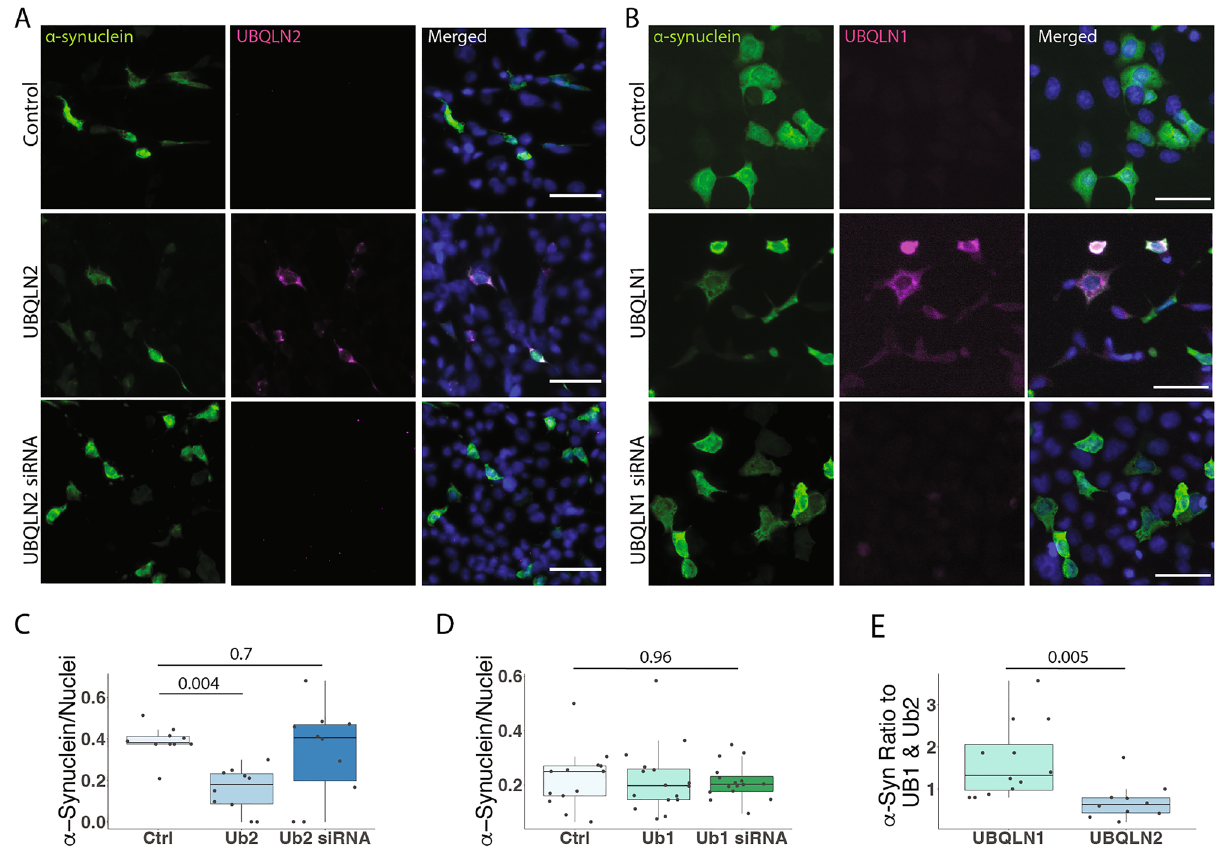
Figure 3. UBQLN2, but not UBQLN1, lowers α-syn levels in HEK-293 cells. ( A – D ) Representative immunofluorescence images show that the number of α-syn-containing cells are decreased when co-expressed with UBQLN2 ( A , C ; n = 10 field of cells over 3 independent experiments) but not with UBQLN1 ( B , D ; n = 10 field of cells over 3 independent experiments). Scale bar 100 μm ( E ) Expressed as a ratio of α-syn positive cells to UBQLN1 and UBQLN2, α-syn is significantly reduced in UBQLN2-expressing